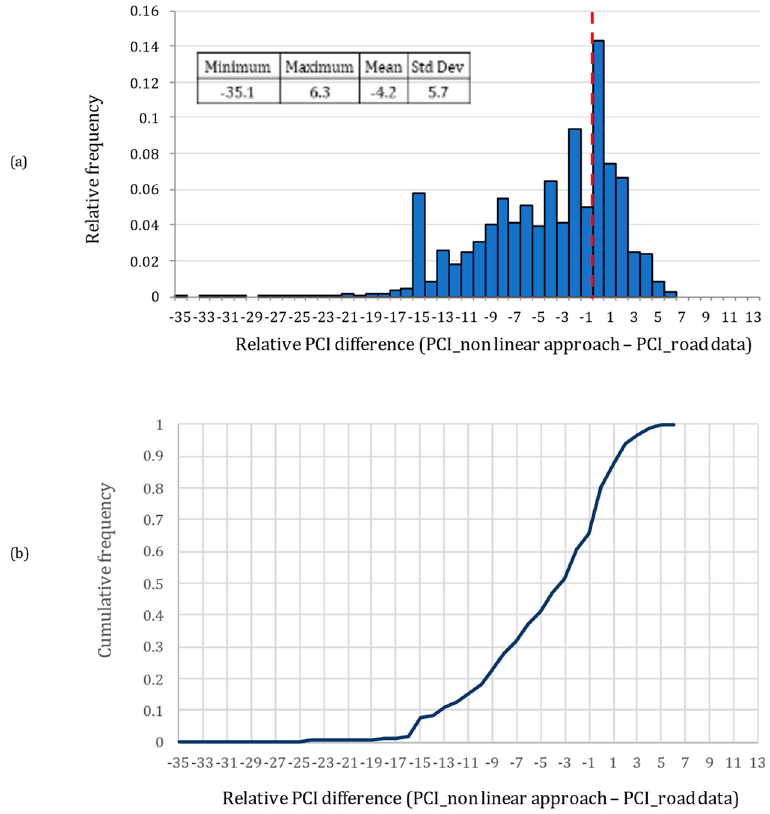
Figure 19. PCI correction due to Bayesian estimator in terms of relative frequency ( a ) and cumulative frequency ( b ).